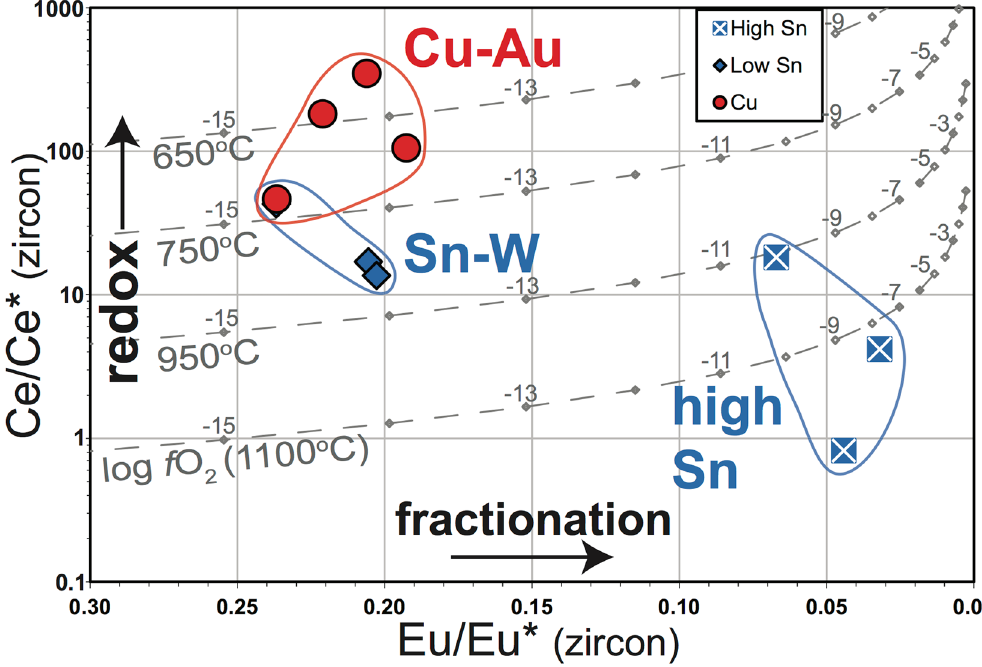
Figure 4. Plot of median zircon Eu/Eu * versus Ce/Ce * . The grey curves represent modelled isothermal covariance of Ce/Ce * with Eu/Eu * as a function of log f O 2 (values annotated) for different temperatures.